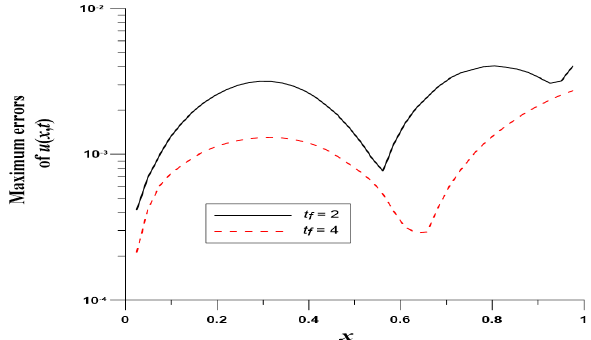
Figure 12. For Example 7 of the backward nonlocal wave problem of the Klein–Gordon equation: ME( u ) versus x with different final times.